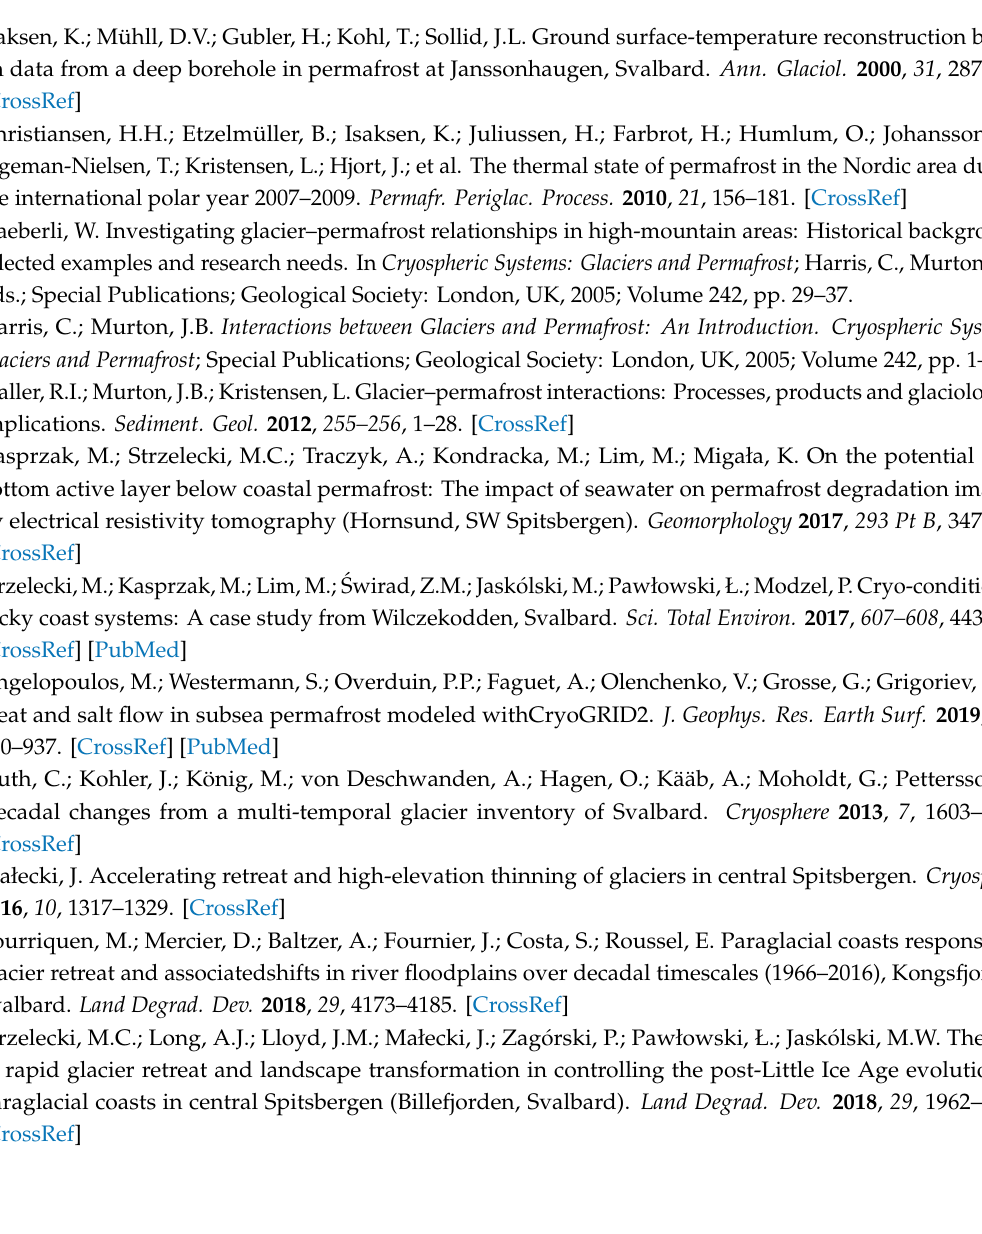
Section 2 is an example.